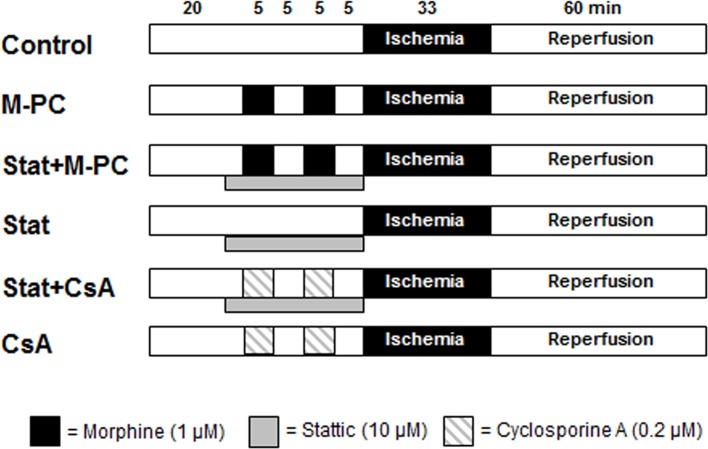
Experimental protocol for in vitro infarct size measurement.Con = control, M-PC = morphine preconditioning, Stat = STAT3 inhibitor stattic, CsA = atractyloside (mPTP blocker).